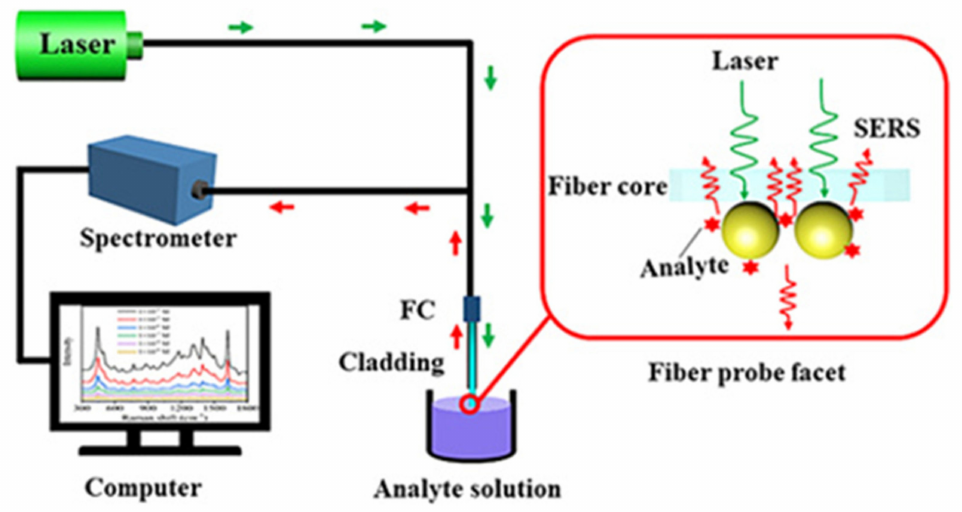
Figure 16. Schematic of experimental set up of SERS sensor based on reflection mode. Reprinted with permission from Ref. [95]. Copyright 2021 Optica Publishing